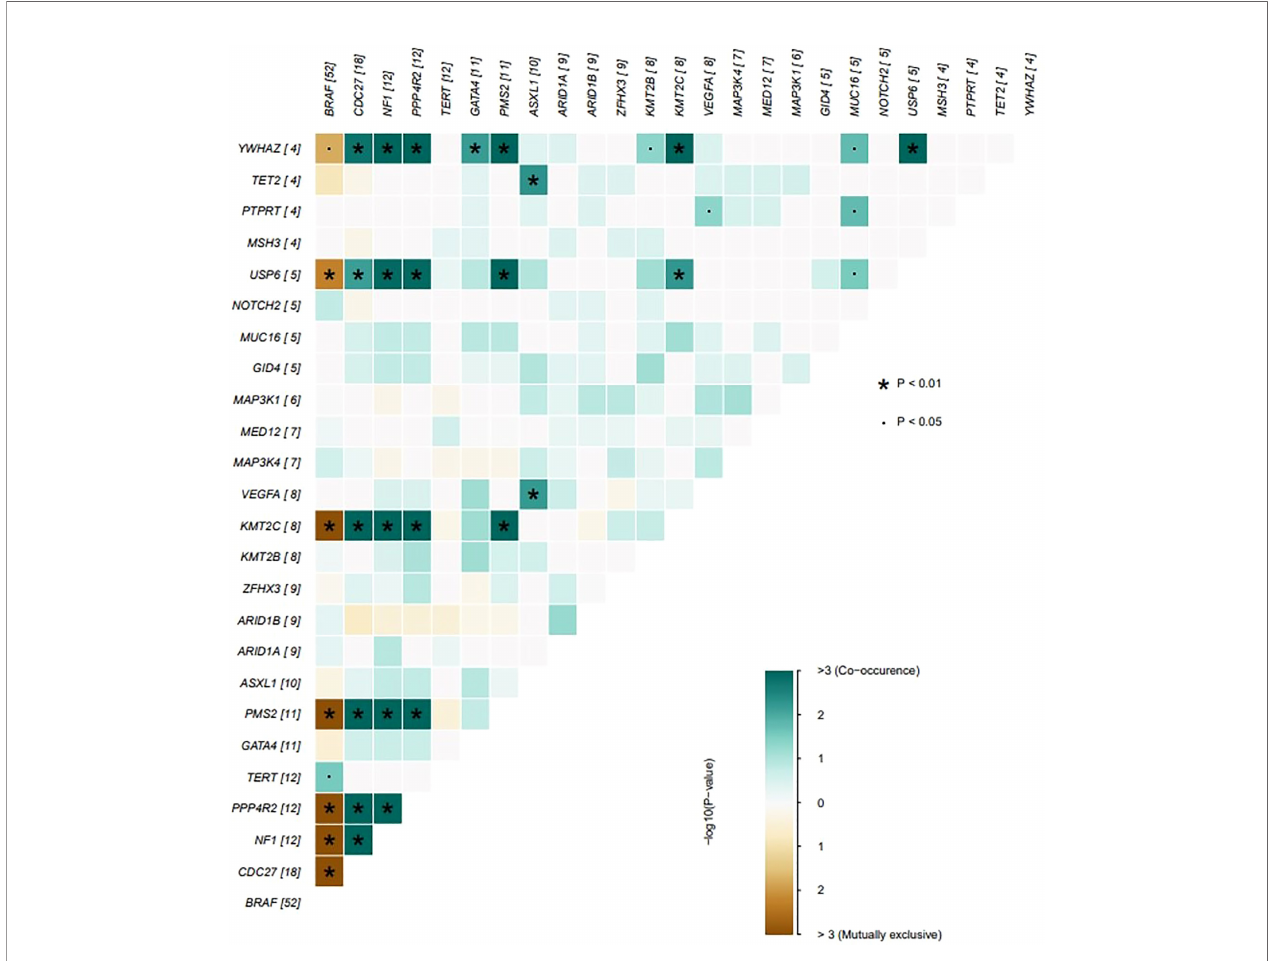
FIGURE 2 | The coincident and exclusive associations across mutated genes. The occurrences of BRAF and NF1/PSM2 mutations were mostly mutually exclusive, * P < 0.01; . P <